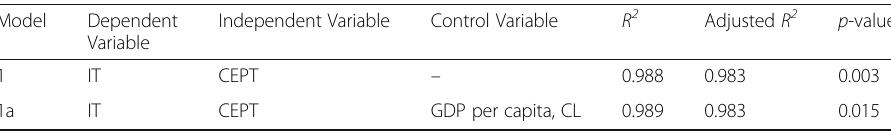
Table 2 Regression Results of Hypothesis